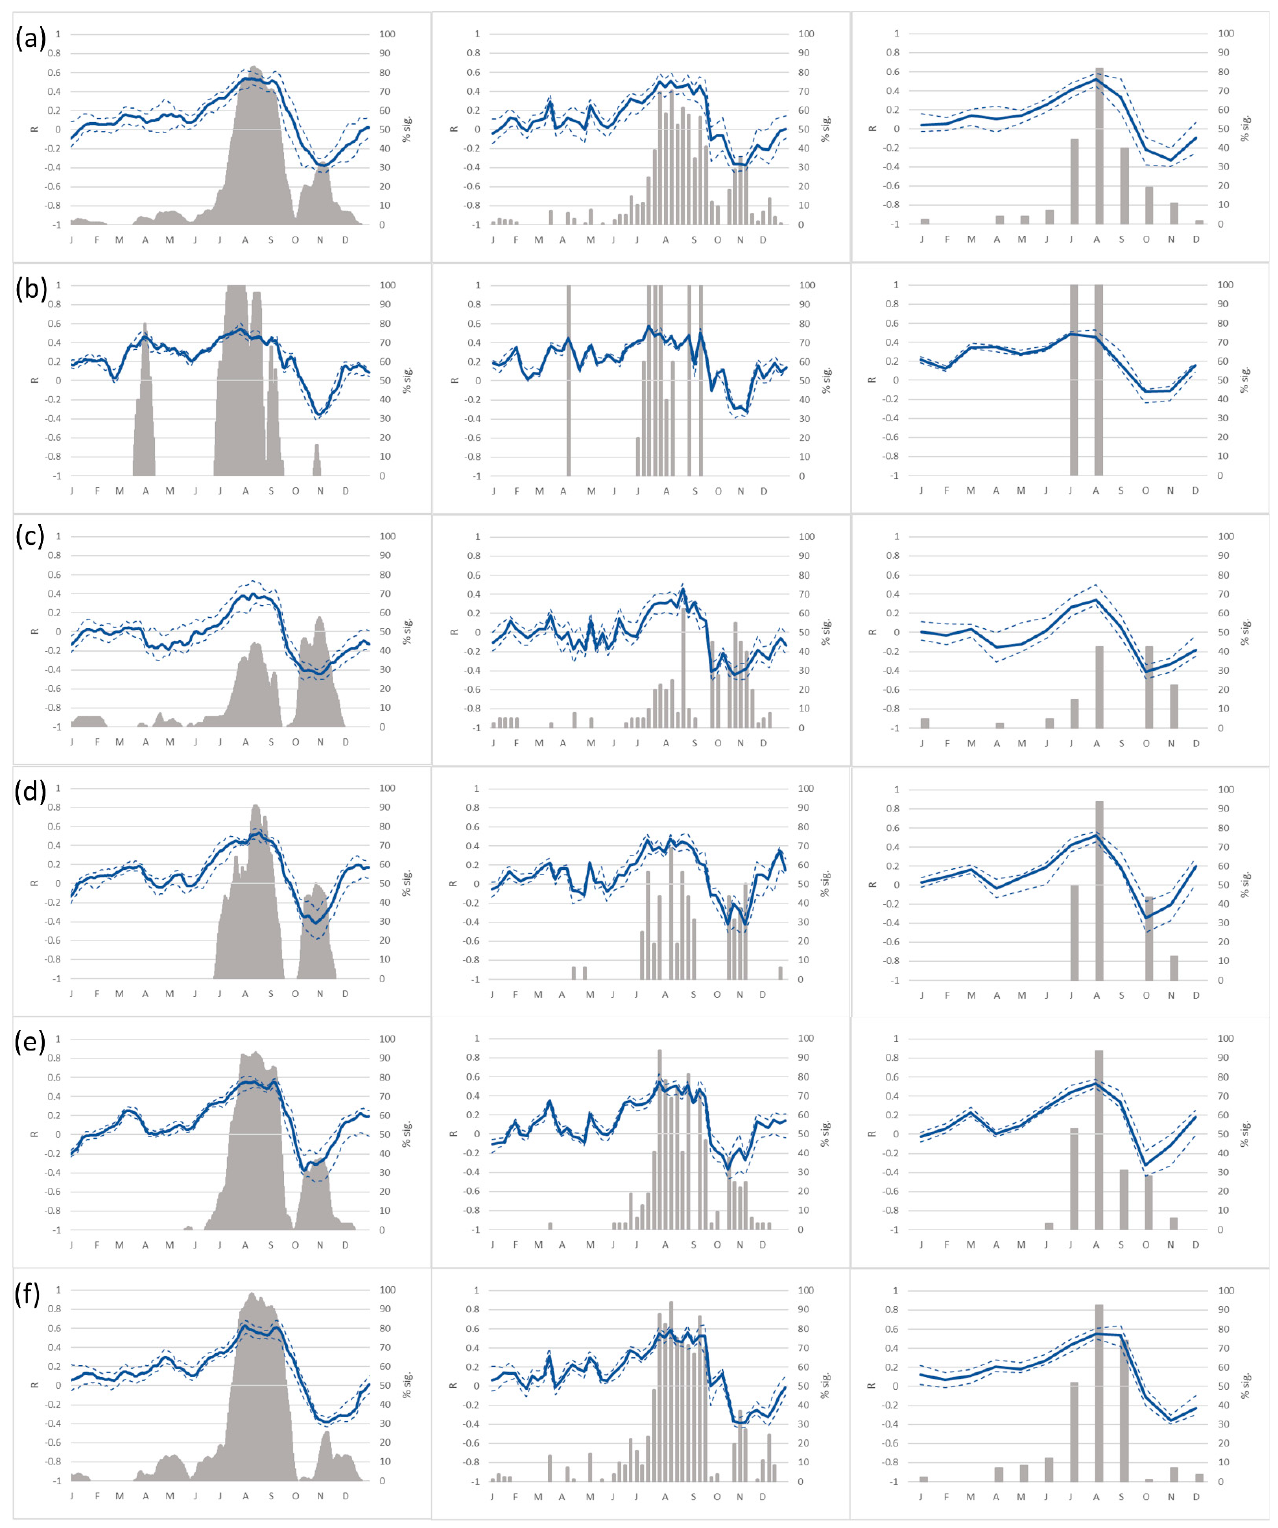
Figure 3. Temporal evolution of percentile 75, percentile 25 (dashed blue lines), median (dark blue line), and percentage of R values with p value < 0.05 (grey bars) obtained with the sample-by-sample approach between SM and black truffle production for daily data (left column), weekly data (middle column) and monthly data (right column). ( a ) Iberian Peninsula; ( b ) Betic Range; ( c ) Pyrenees; ( d ) North Iberian Range; ( e ) Central Iberian Range; ( f ) South Iberian Range.